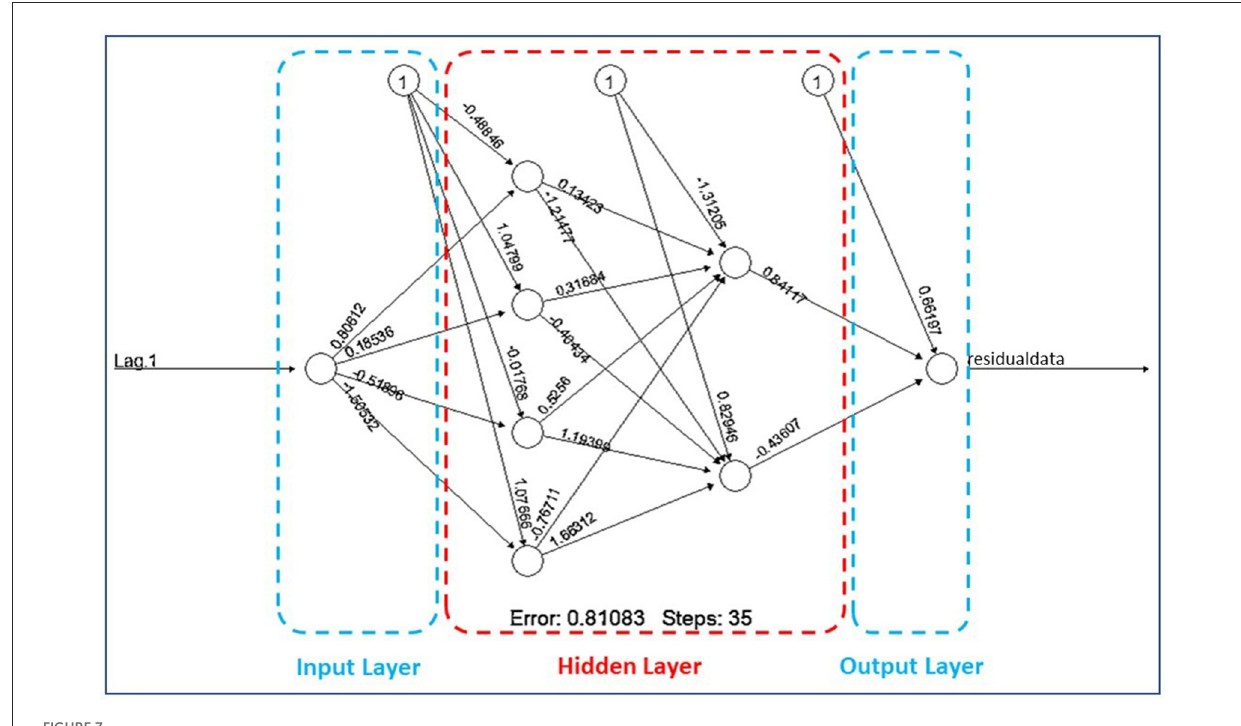
FIGURE7 Architecture 1 − 4 − 2 − 1 of FFNN model with their weights for each unit.